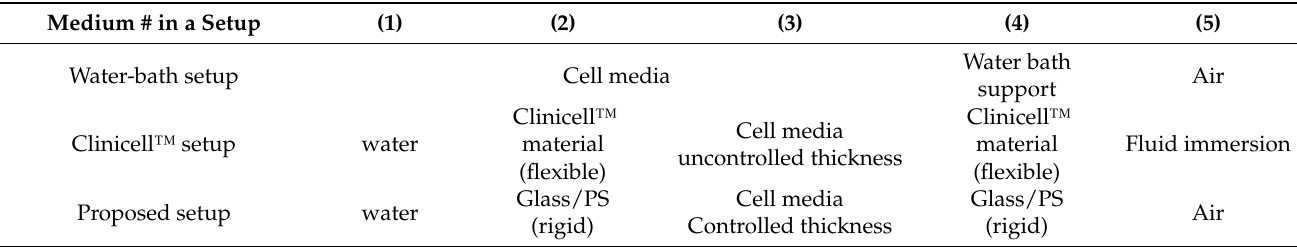
Table 1. Differences and similitudes between regular setups for cell and microbubbles exposure to US and the newly designed setup characterized here.